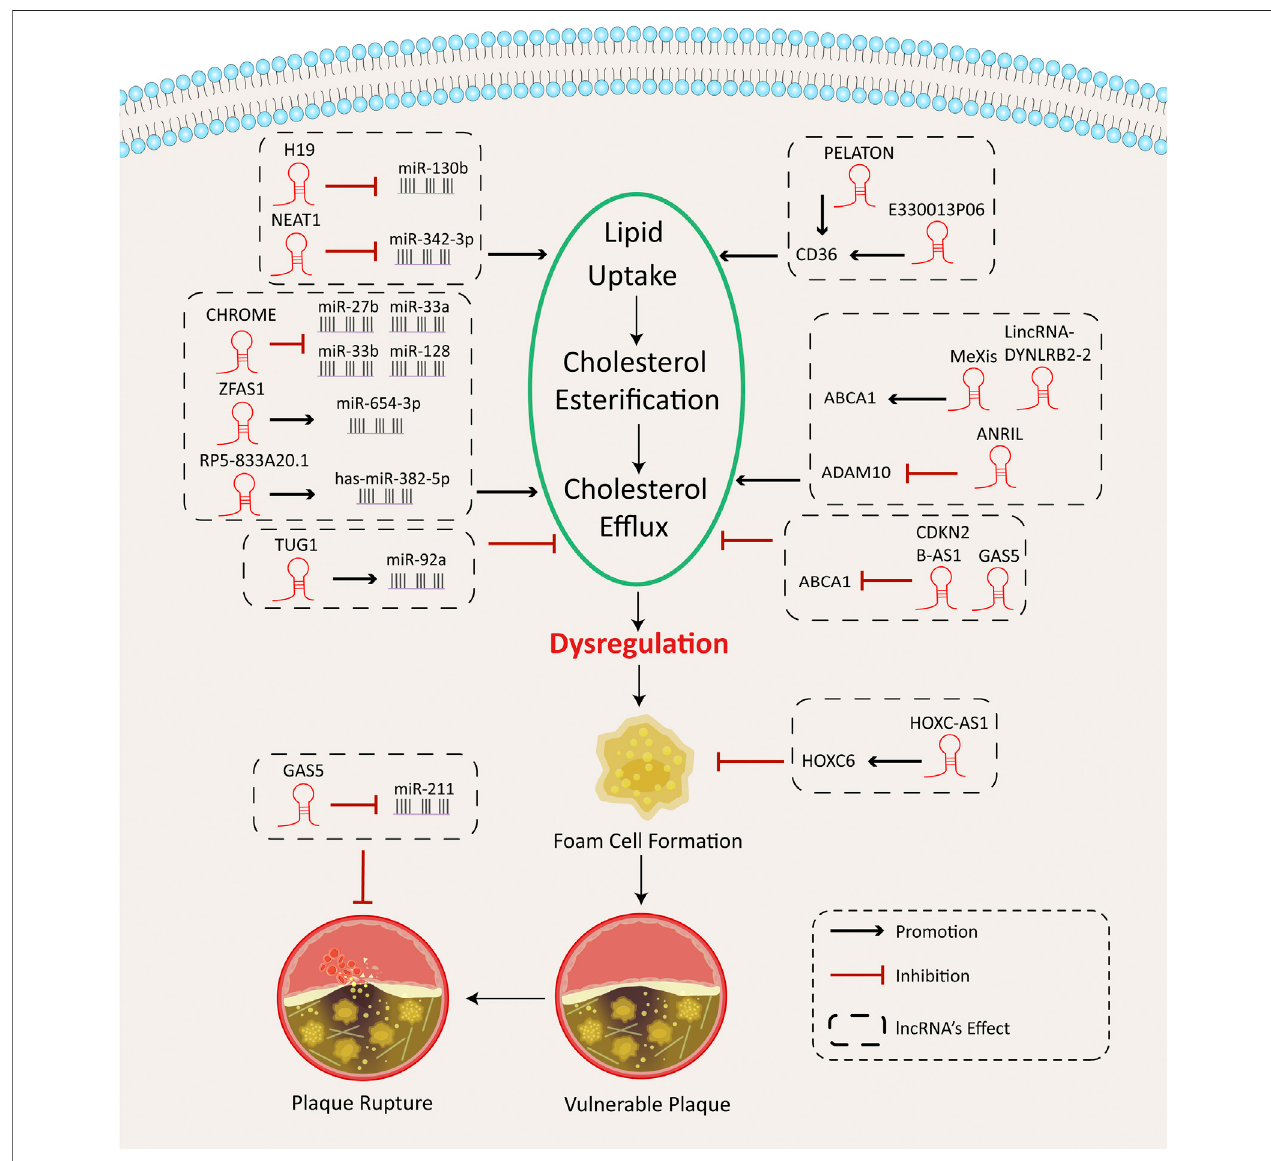
FIGURE 2 | Cholesterol metabolism functions of lncRNAs in